Question: Condense the content of this figure into a single sentence.
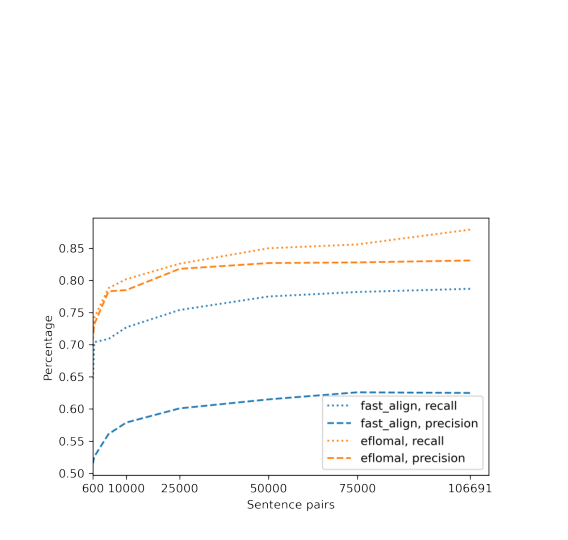
Answer: Performance of our baseline statistical models with relation to the dataset size.